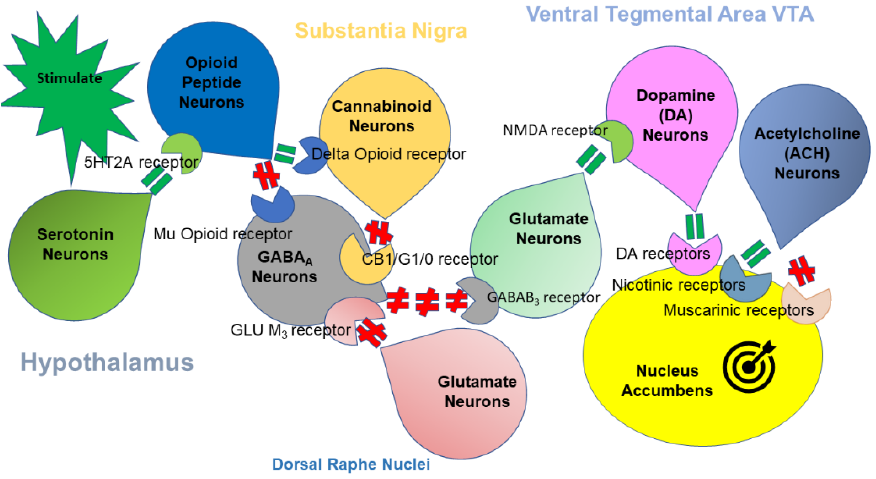
Figure 1. The Brain Reward Cascade with the major neurotransmitter systems involved; green equal sign indicates stimulation and red pound sign stands for inhibition. Stimuli-induced serotonin re- lease in hypothalamus activates 5HT 2a receptors leading to release of hypothalamic opioid peptides. The latter exerts opposite effects via two distinct opioid receptors: (a) inhibition via µ opioid recep- tor, e.g., GABA A neurons in substania nigra and (b) stimulation of cannabinoid neurons (e.g., anan- damide and 2-archydonoglcerol) via β–endorphin linked δ receptors inhibiting GABA A neurons at the substania nigra. GABA A neurons in the substania nigra may be also indirectly disinhibited by cannabinoids, 0 in hedonic and motivational responses [20]. 1.2. Dopaminergic Aspects of Addictive Behvaior Dopaminergic brain systems play a central role in natural reward and motivation and are the main neural substrates for the actions of abused chemical substances and nat- ural rewards alike [21]. Early discoveries by Blum and Noble of alcoholism-related genes laid the foundation for the modern field of Psychiatric Genetics [22]. Excessive exposure to natural stimuli, like palatable food or high-thrill behaviors (e.g., gaming or gambling) as well as to chemical substances (e.g., opioids or cocaine) may alter brain reward circuits via epigenetic mechanisms [23] and other types of neuroplasticity [17,19,24] such as pro- tracted transcriptional mRNA expression [25] which eventually bring about addictive be- havior, characterized by diminished sensitivity to natural rewards (i.e., reward deficiency syndrome (RDS). RDS can be manifested by compensatory engagement in pursuit of re- warding stimuli regardless of adverse consequences [26,27]. Therefore, RDS has been linked to opioids, other drugs [28,29], and comorbid neuropsychiatric syndromes [30–33]. These insights supported the definition of “addiction” as a brain disorder [34] by the American Society of Addiction Medicine, spurring cross-fertilizing interactions between clinical and basic research. Nowadays, addiction science is well positioned to comprehend the true nature of the brain disorder through the prism of genomic medicine. Brain disorders characterized by RDS are diverse and complex from both clinical and genetic standpoints. The difficulty of several genome-wide association studies (GWAS) in finding significant associations with various gene candidates may stem from several fac- tors including clinical heterogeneity, polygenic nature of phenotypic targets, and lack of adequate controls. Such difficulties notwithstanding, using genome wide association studies (GWAS), Hancock et al. [35] identified 11 genetic loci for smoking, 8 loci for alco- hol, and 2 loci for illicit drugs combined. Thus, we may need to consider various neuro- transmitter-informed RDS subtypes based on their predominantly serotonergic-, canna- binoidergic-, endorphinergic-, opioidergic-, glutaminergic-, or dopaminergic nature . At the same time, it is important not ‘to miss the forest for the trees’ as we are still striving for the discovery of coherent laws that will unite the prevailing models of RDS to generate